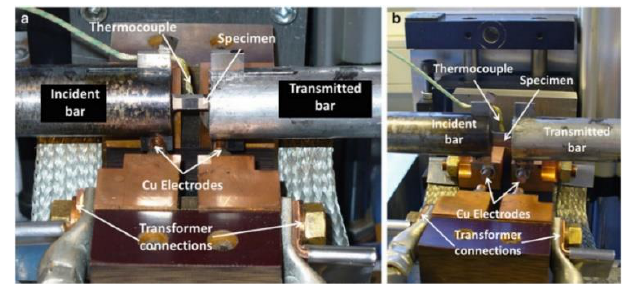
Figure 3: Copper electrode system for direct electric heating, Viscasillas [8].